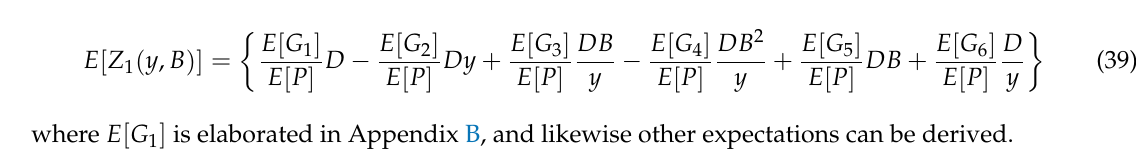
Table 2. Different cases of trade credit based on different values of M , N and T . Cases Immediate Payment Part Delayed Payment Part